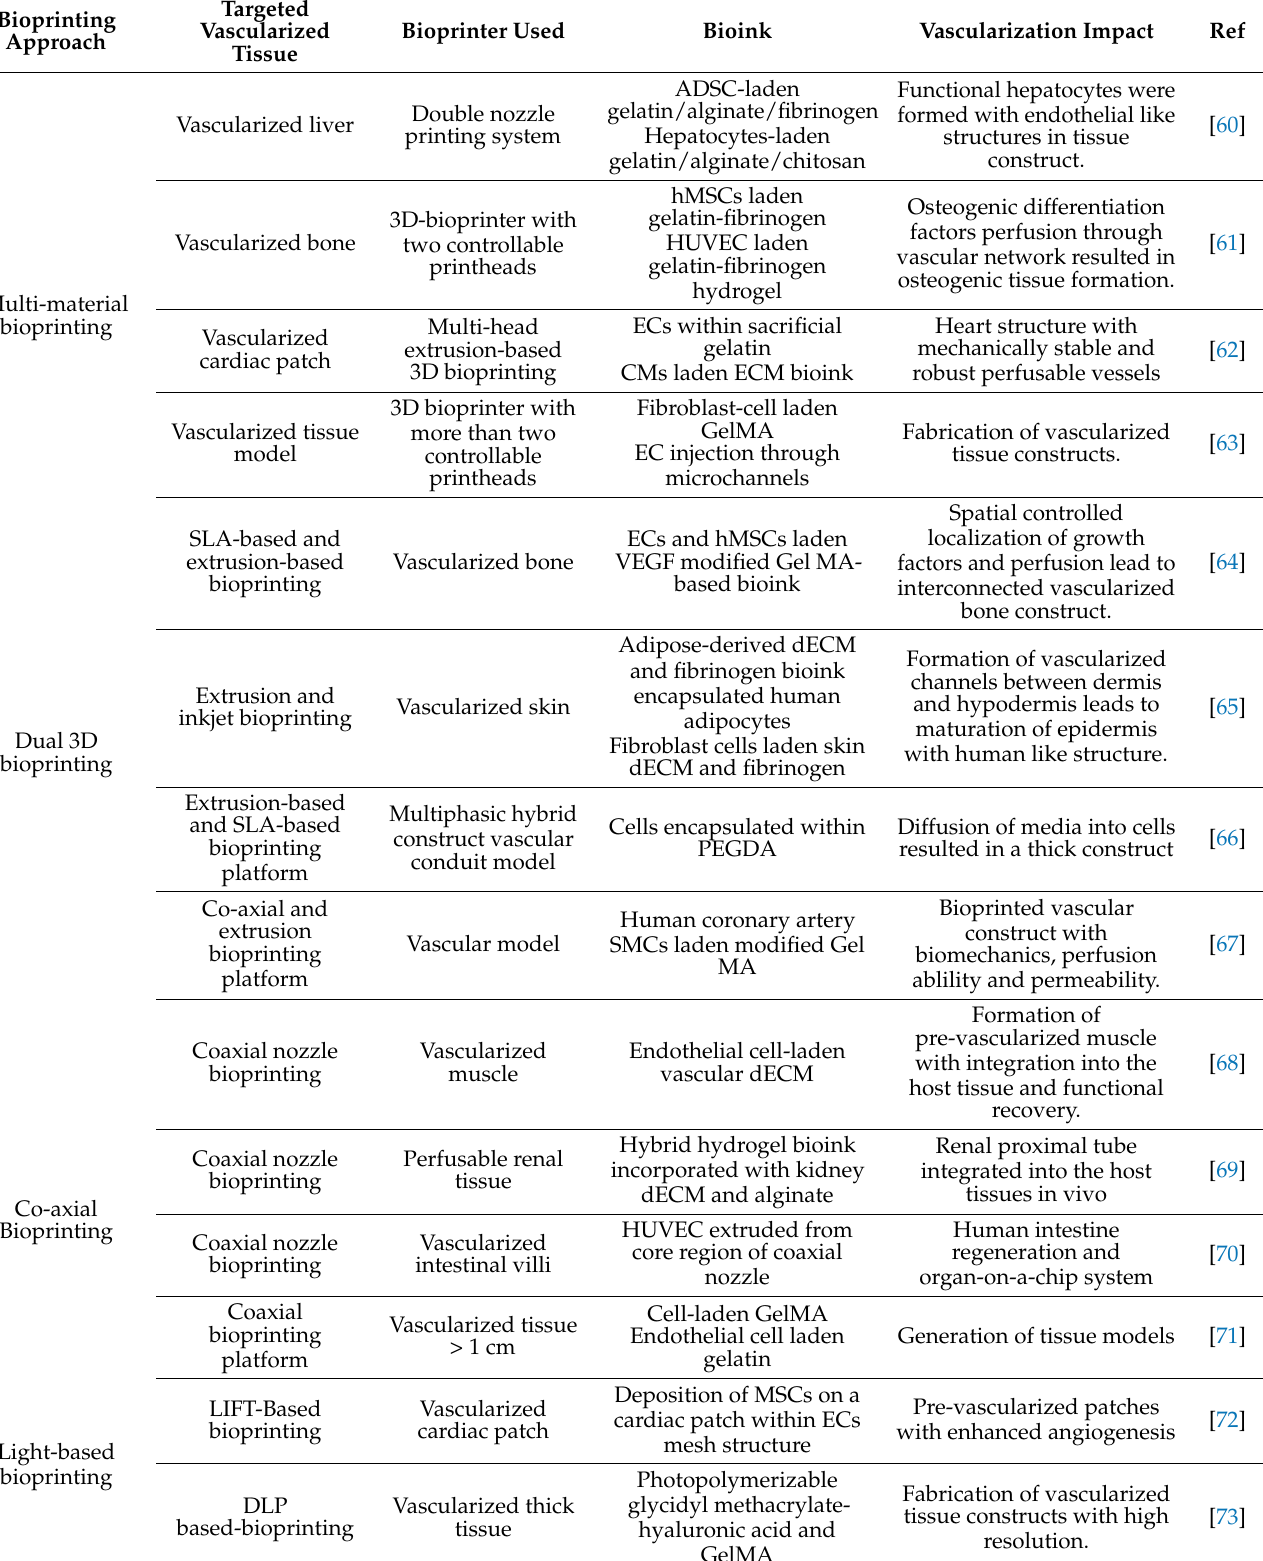
Table 3. Multi-material bioprinting strategies for generation of vascularized